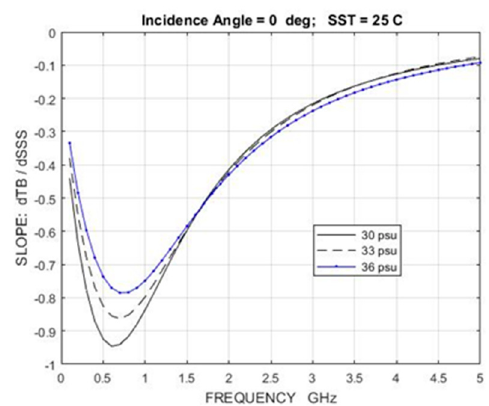
Figure B2. Dependence on salinity of the sensitivity of brightness temperature to changes in salinity, dTB/dSSS, as a function of frequency. The examples are for nadir, SST = 25 ℃ and WS = 0 m/s and made using the Klein-Swift model function [19].